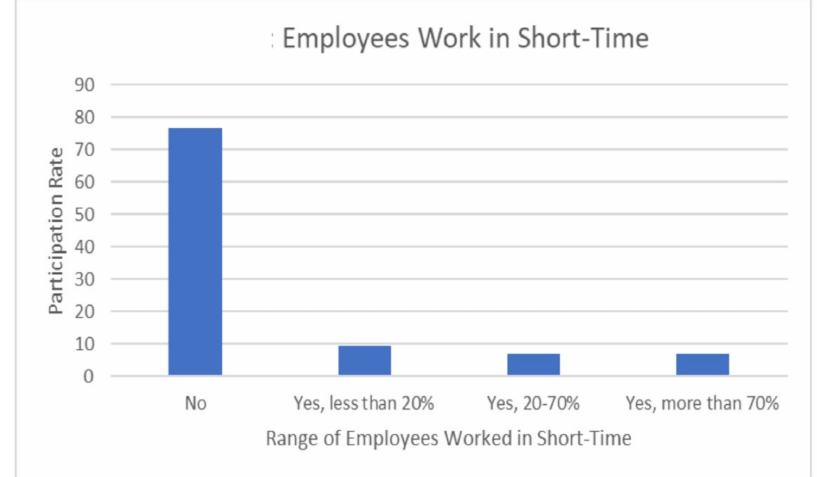
Figure 5. Radiology workers and short–time duty during the COVID-19 crisis.